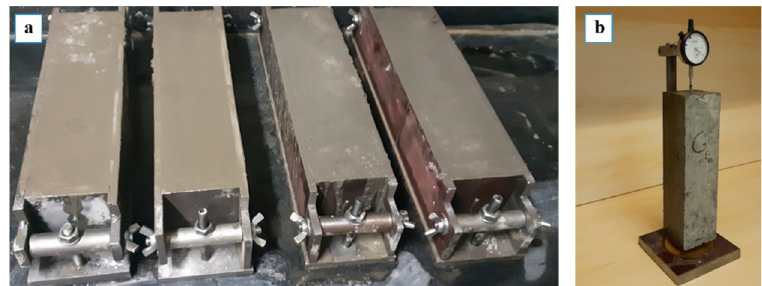
Figure 2. Concrete prism samples: ( a ) casting; ( b ) length measuring